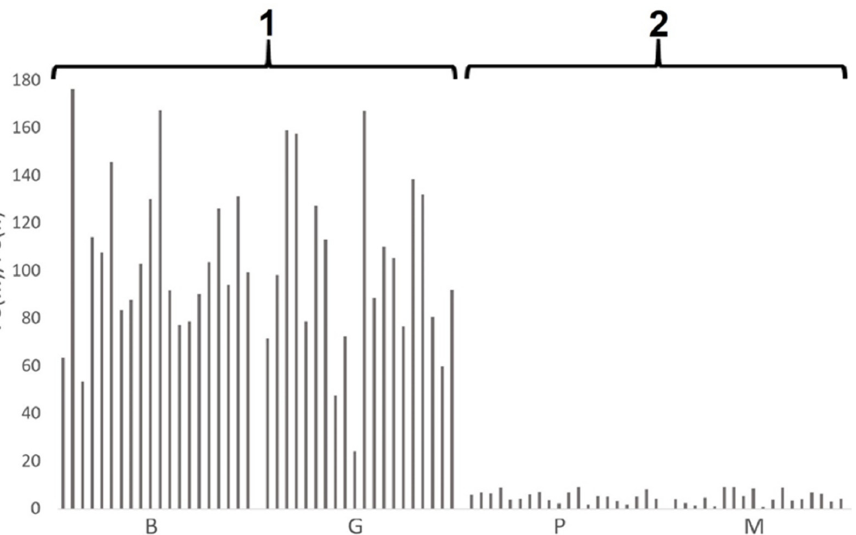
Figure 3. The Fe(III)/Fe(II) ratio for samples from sites Borzejewo (B), Pozna ń -Nowe Miasto (P), Grabkowo (G), Moldova(M); 1—the group of samples with Fe(III)/Fe(II) ratio greater than 20 (sites (Borzejewo (B) and Grabkowo (G))); 2—the group of samples with Fe(III)/Fe(II) ratio less than 20 (sites (Pozna ń -Nowe Miasto (P) and Moldova(M))).